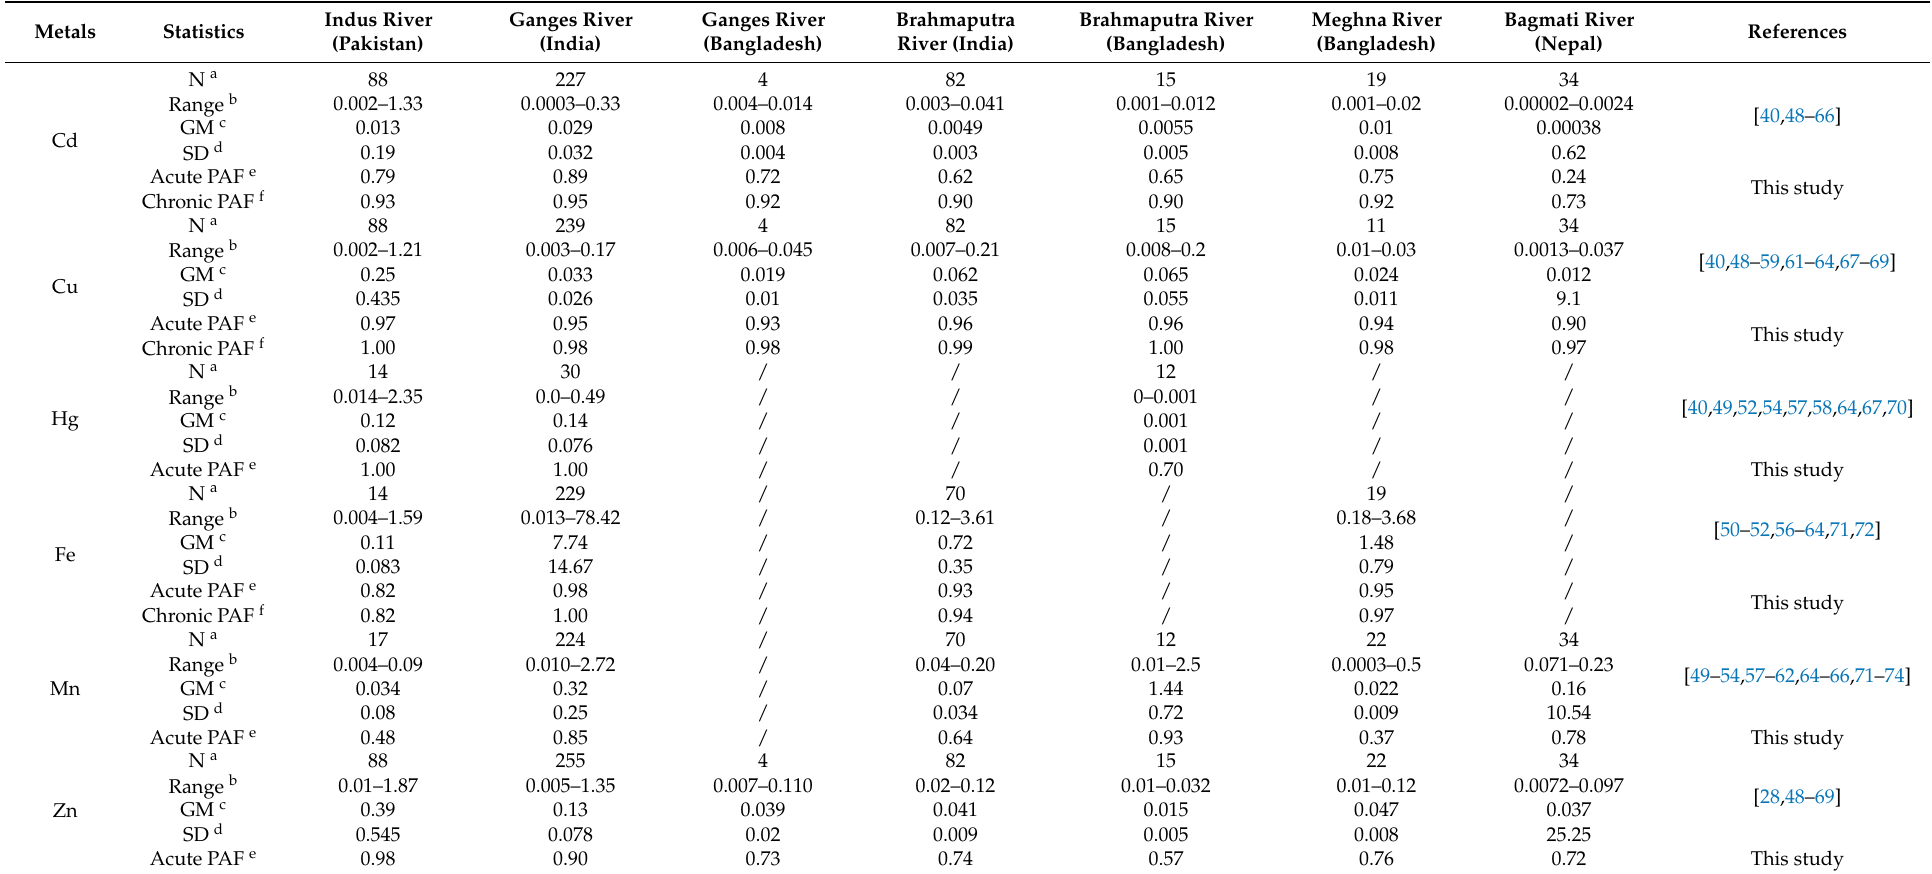
Table 3. Summary of the detected concentrations (unit: mg/L) collected from previous studies and acute and chronic PAF values calculated based on established NPKDE-SSDs of six transition metals in five South Asian